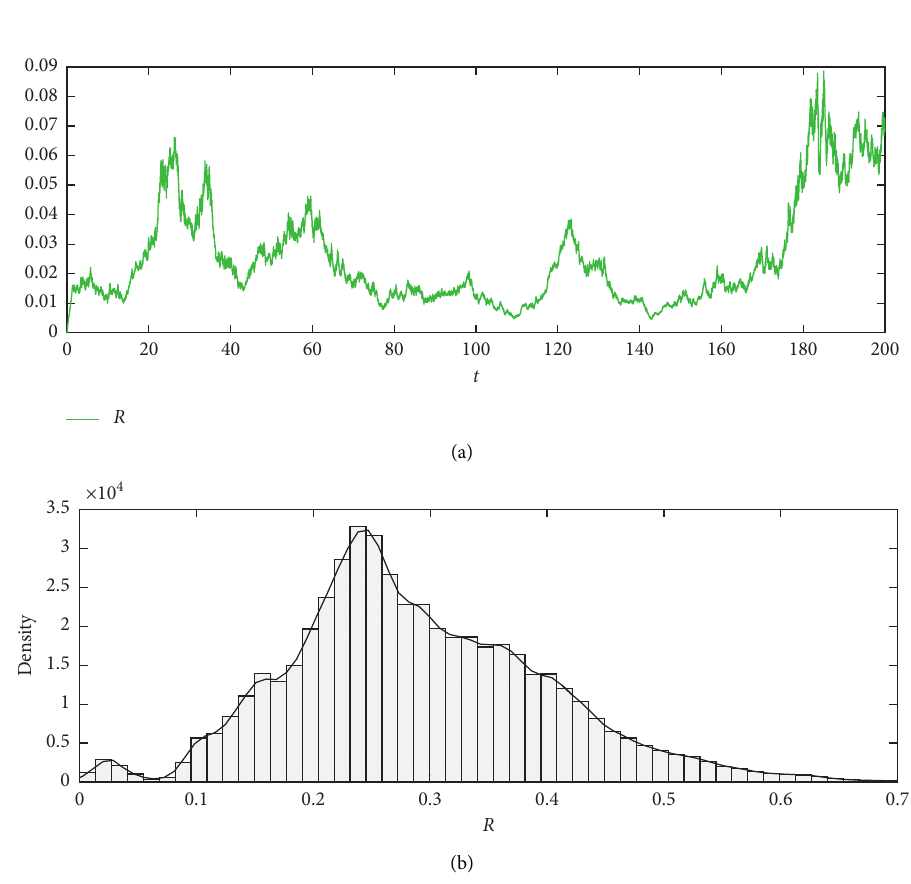
Figure 5: The solution R(t) of stochastic model (3) and its